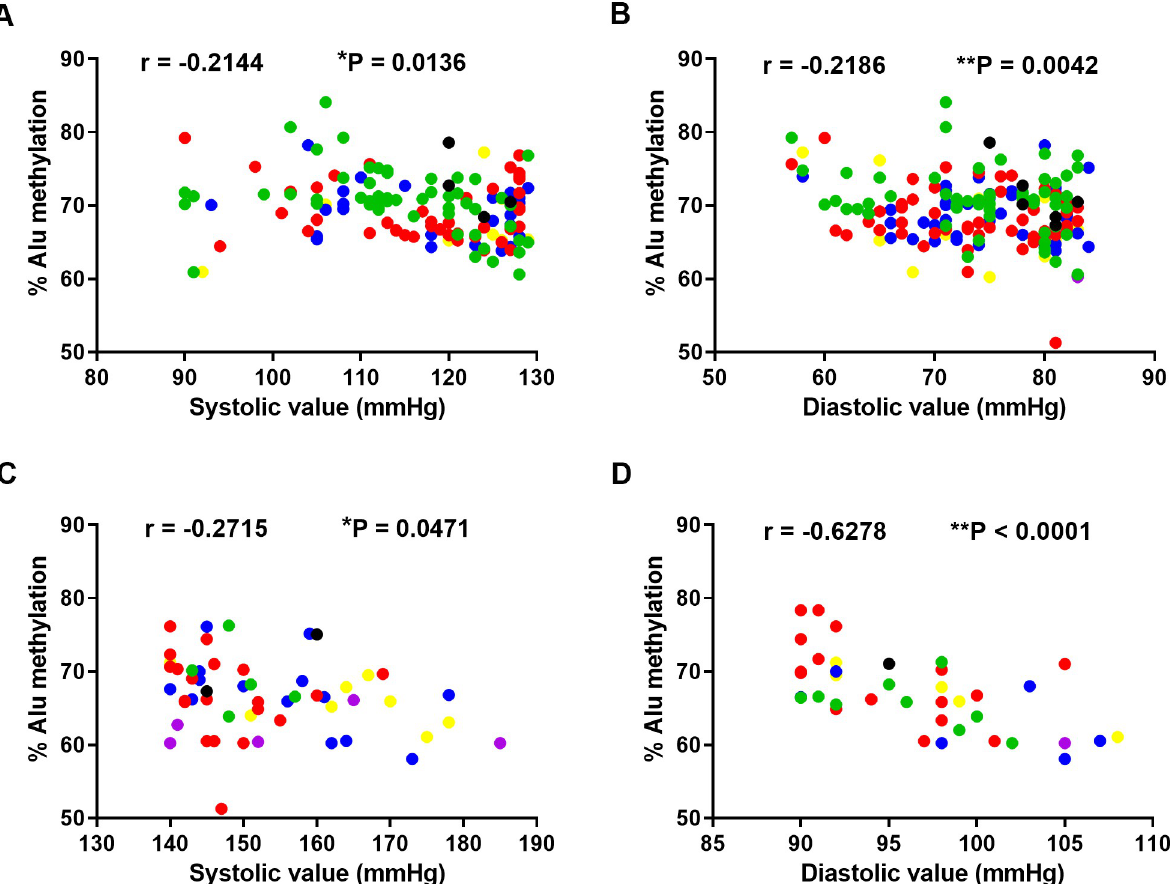
Fig 2. The association between Alu methylation and blood pressure. The color representation of the range of age using the black color (31–40 years), green color (41–50 years), red color (51–60 years), blue color (61–70 years), yellow color (71–80 years), and violet color (81–90 years). Correlation between the % Alu methylation and systolic pressure in normal controls (A) and hypertensive patients (C). Correlation between Alu methylation and diastolic pressure in normal controls (B) and hypertension patients (D). Pearson’s correlation coefficients (r) with P values are indicated ( � P < 0.05, �� P <